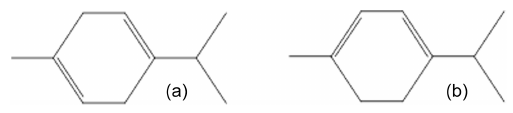
Figure 1. Molecular representation of γ -terpinene (a) and α - terpinene (b)